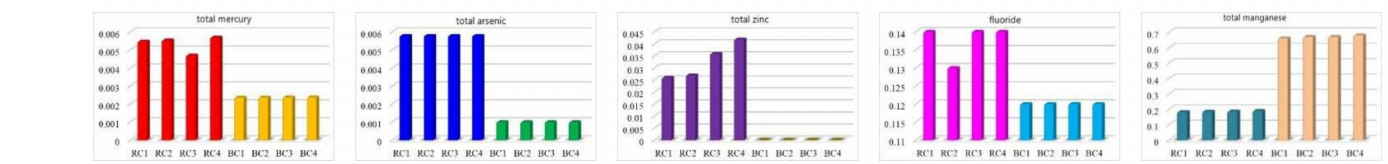
Figure 6. Analysis results of pollutants in Hongshaquan and Heishan coal samples.